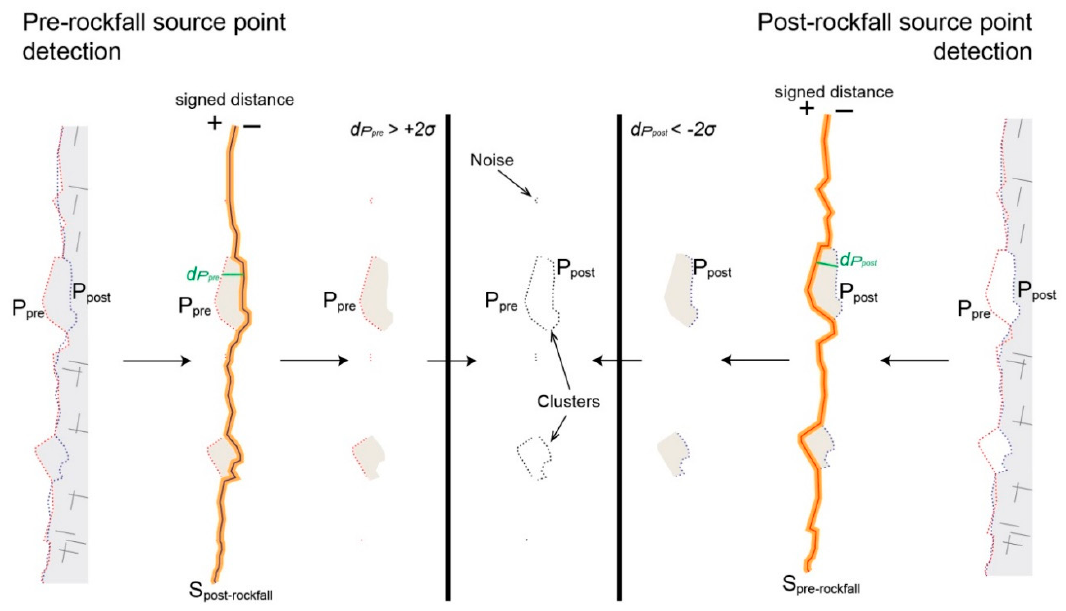
Figure 1. Sketch of the process of localizing rockfall sources. Where P are the points, S is the reconstructed surface from point cloud at different epochs, and d P is the difference in distance from the point-to-surface comparison. The subscripts pre and post denote pre- and post-rockfall event acquisition, respectively.